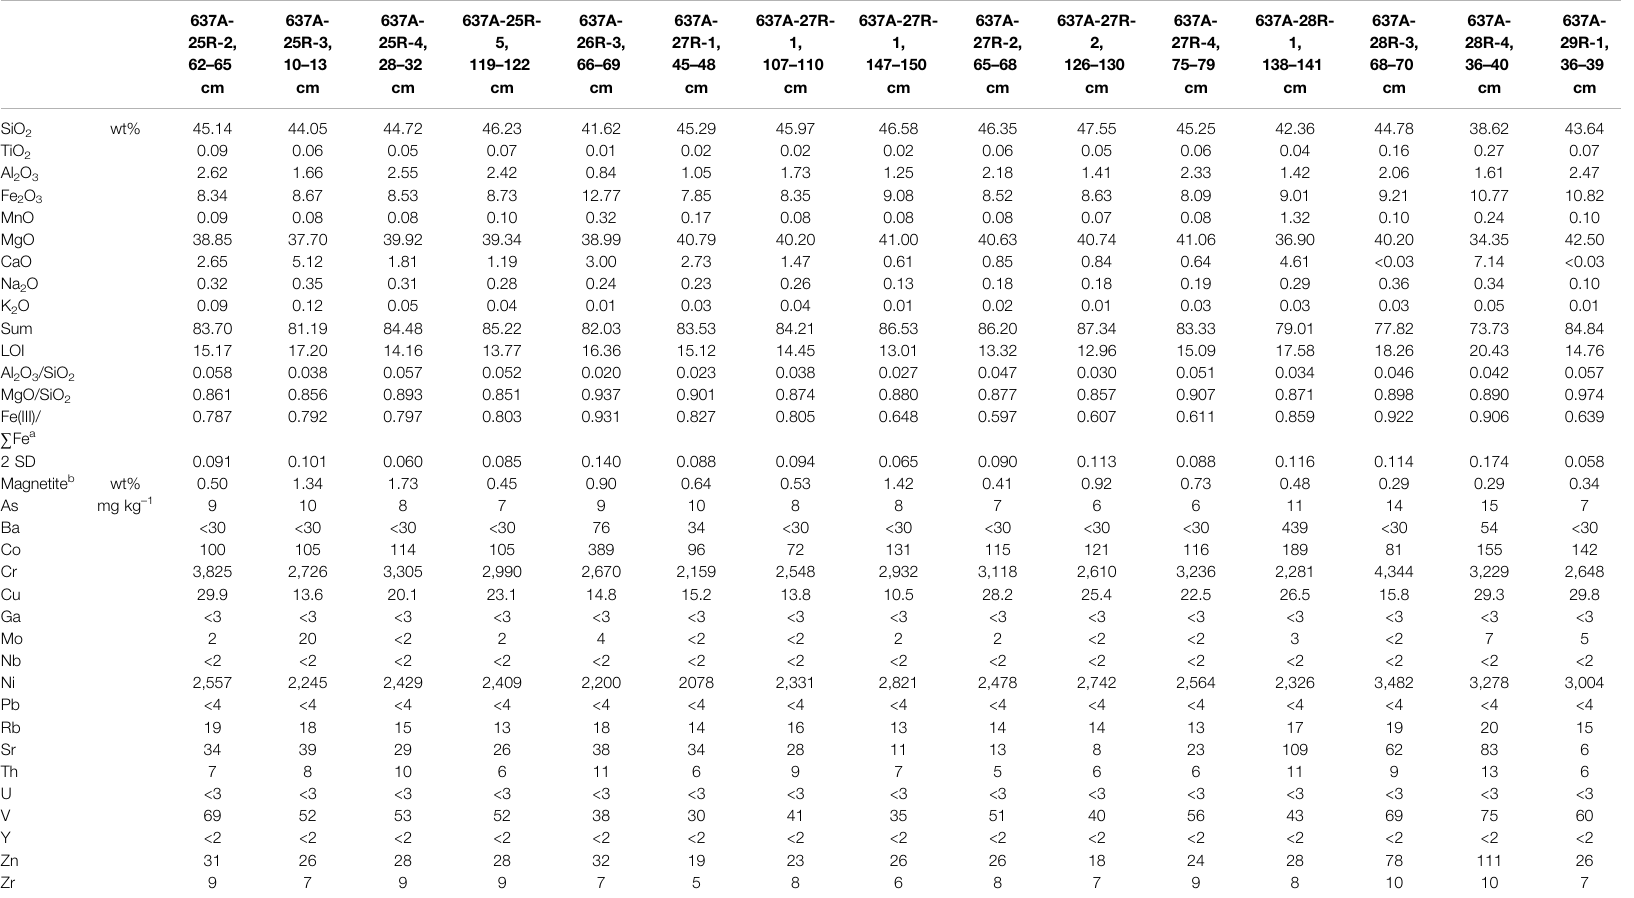
TABLE 2 | Corrected bulk rock geochemistry, Fe oxidation state, and magnetite contents of the Hole 637A